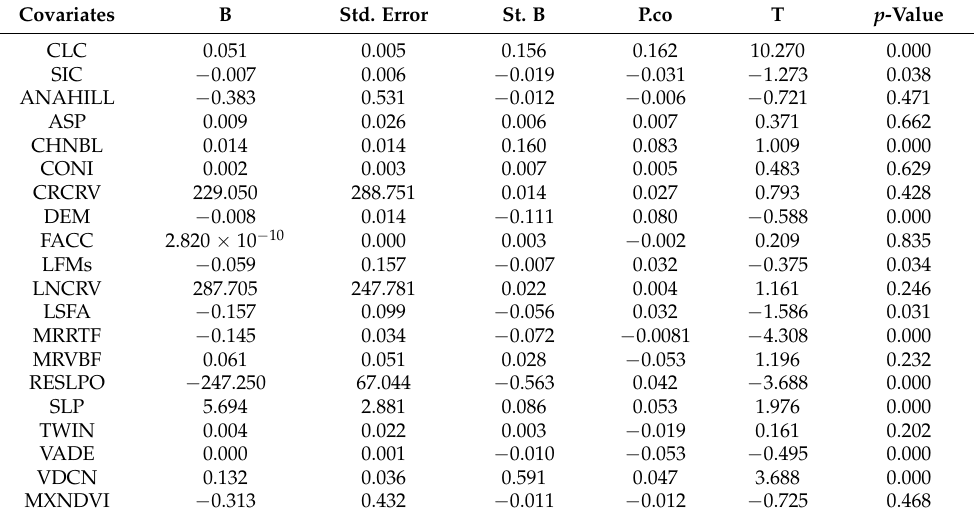
Table 7. Sensitivity analysis of related sets of covariates results. Covariates B Std. Error St. B